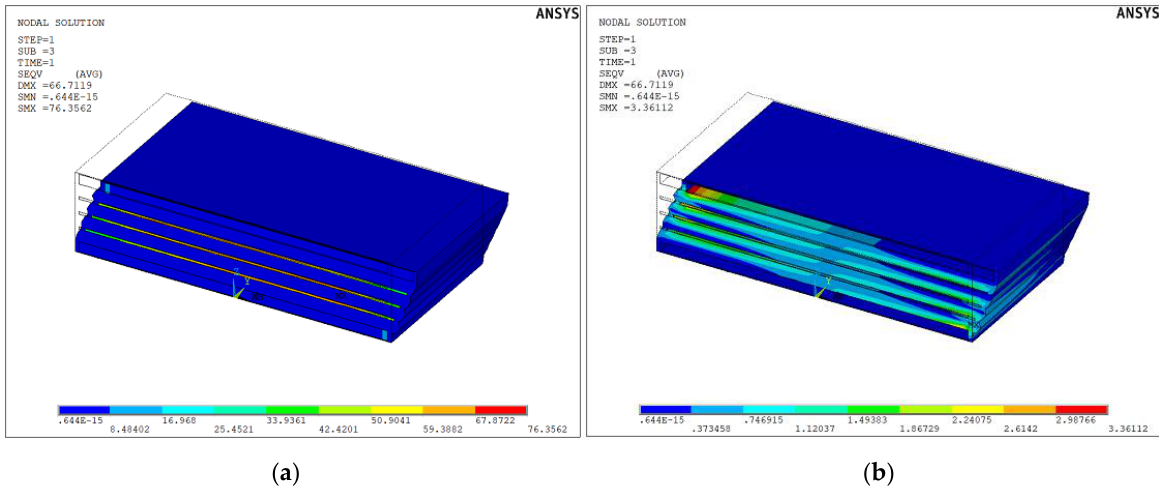
Figure 8. Stress distribution of elastomeric bearing with 2P M-R model as shear strain is 0.5 under the vertical pressure of 6 MPa: ( a ) for all domain; ( b ) for elastomer only.